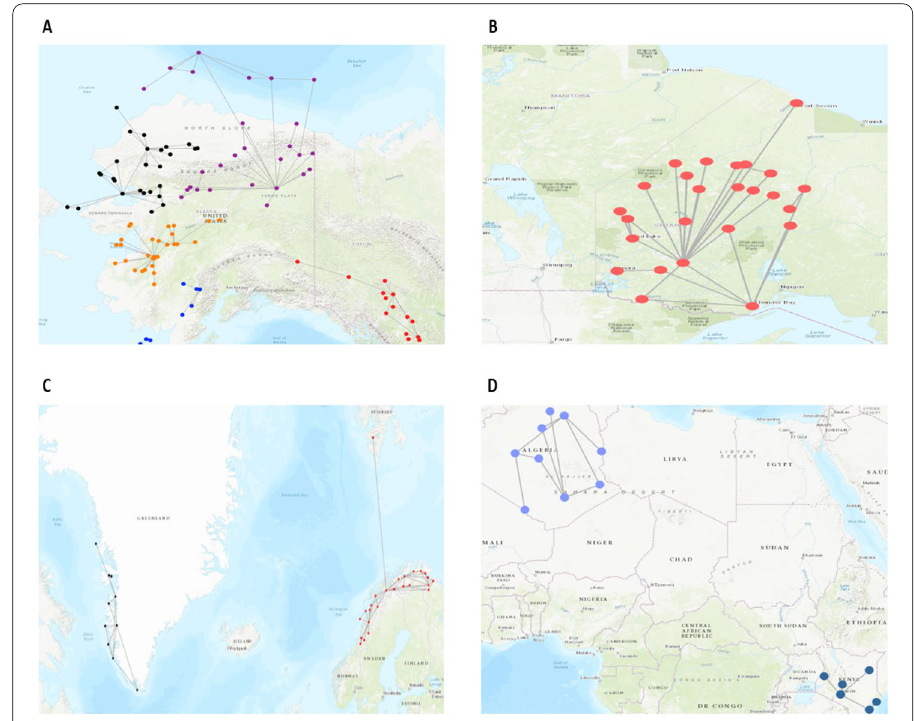
Fig. 17 Small local components (size greater than 5 nodes). A Small components located in Alaska (USA). B small components in Ontario (Canada). C Small components in Green-Land and Norway (Europe). D Small component in Algeria and Kenya